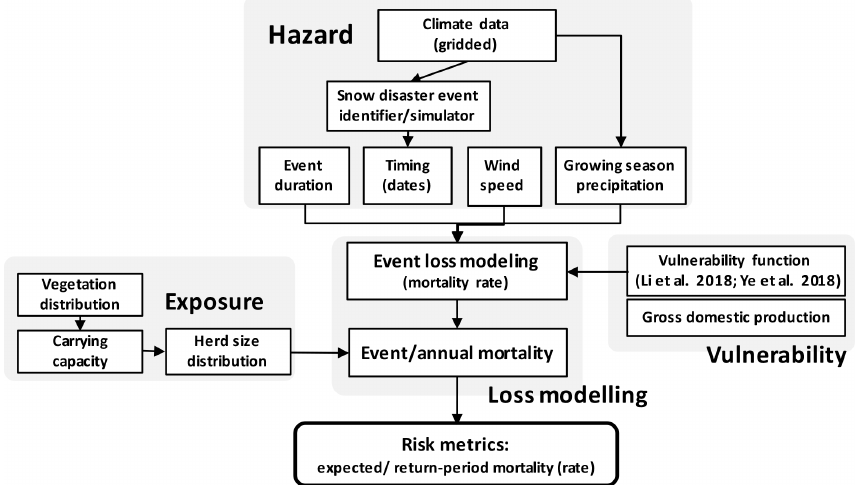
Figure 1. Event-based probabilistic risk assessment framework for livestock snow disasters in the Qinghai–Tibetan Plateau region.